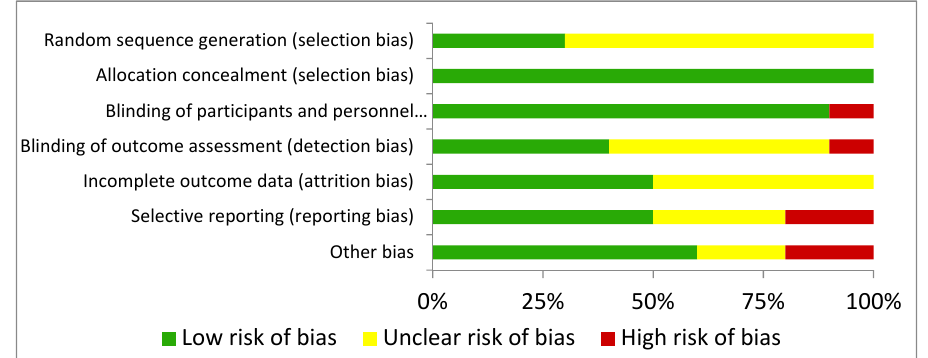
Figure 3. Risk of bias graph: review authors’ judgements about each risk of bias item for each included study.